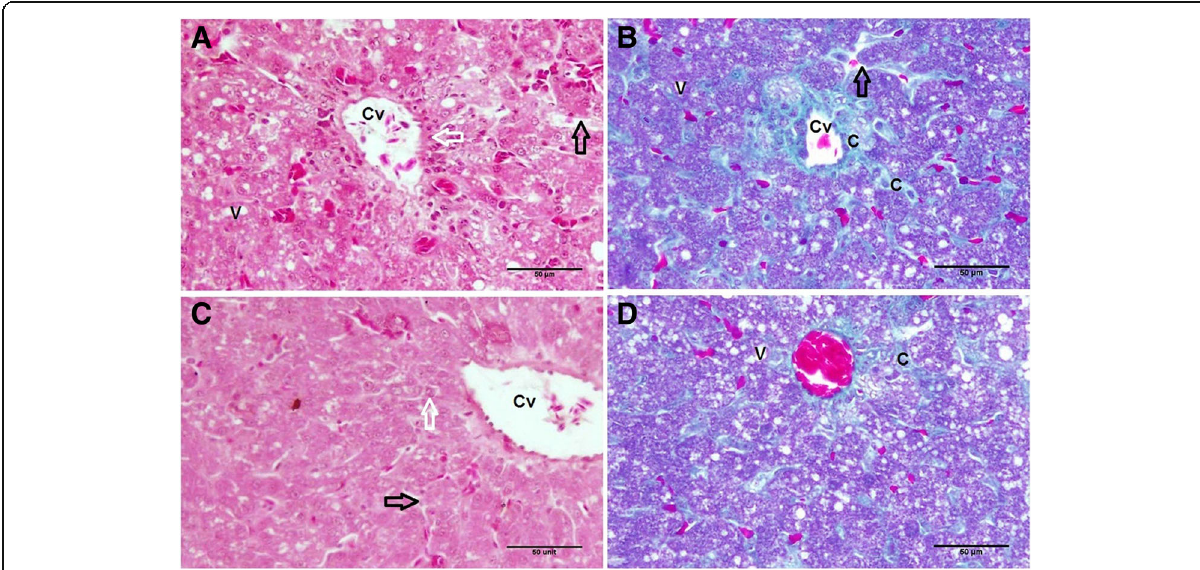
Fig. 3 Hepatic tissue photomicrograph of the wheat diet group stained with H&E stain ( a ) and crossmon trichrome stain ( b ) illustrating the presence of vacuolated hepatocytes (V), swollen hepatic sinusoids (black arrow), with some inflammatory cell infiltrations (white arrow) and collagen fiber depositions (C) around central vein (Cv) and hepatic sinusoids. c , d Photomicrographs of the liver tissue stained with H&E stain ( c ) and crossmon trichrome stain ( d ) clarifying the protective effect of water bath presence under heat stress condition. Note the normal hepatocytes (white arrow) in cords, small-sized sinusoids (black arrow), and thin-walled central vein (Cv); however, degree of hepatocytes vacuolation (V) and collagen deposition (C) were found, bar=50 μ m